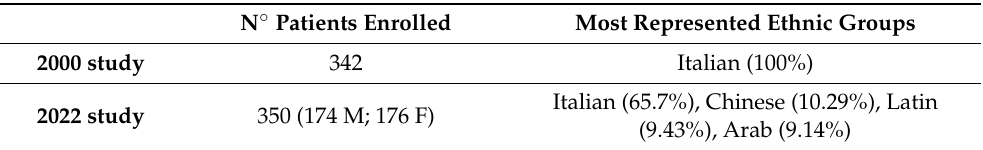
Table 14. Comparison of the number and ethnic groups of patients enrolled in the epidemiological studies of 2000 and